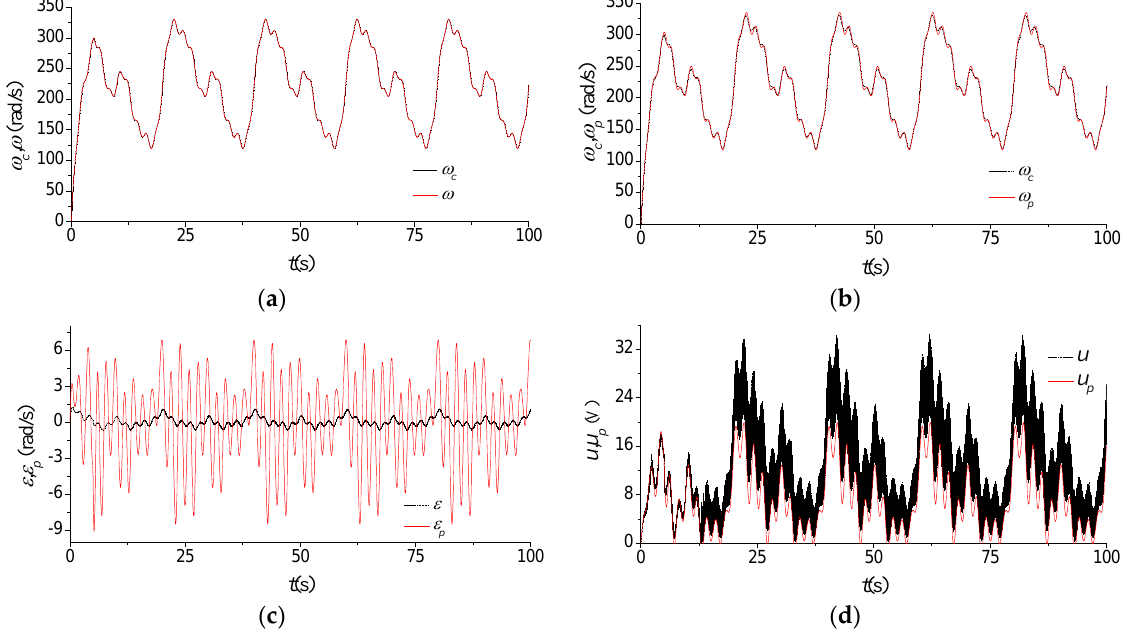
Figure 9. Comparisons of some experimental results of two types of control schemes in a wide range of rotational speeds: ( a ) ω c and ω ; ( b ) ω c and ω p ; ( c ) ε and ε p ; ( d ) u and u p .